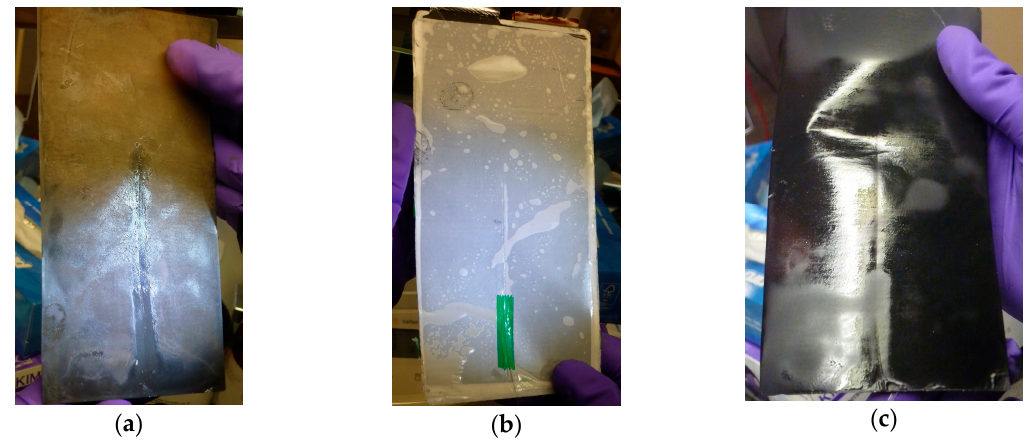
Figure 15. Post-mortem examination of a battery cell provided with a surface Bragg grating within the double layered separator: ( a ) On the backside of the anode material, focusing on the separator, imprints from the light waveguide are recognizable; ( b ) shown is one layer of the separator with the overlying glass fiber; ( c ) in this photograph, the cathode active material side facing the separator is focused.